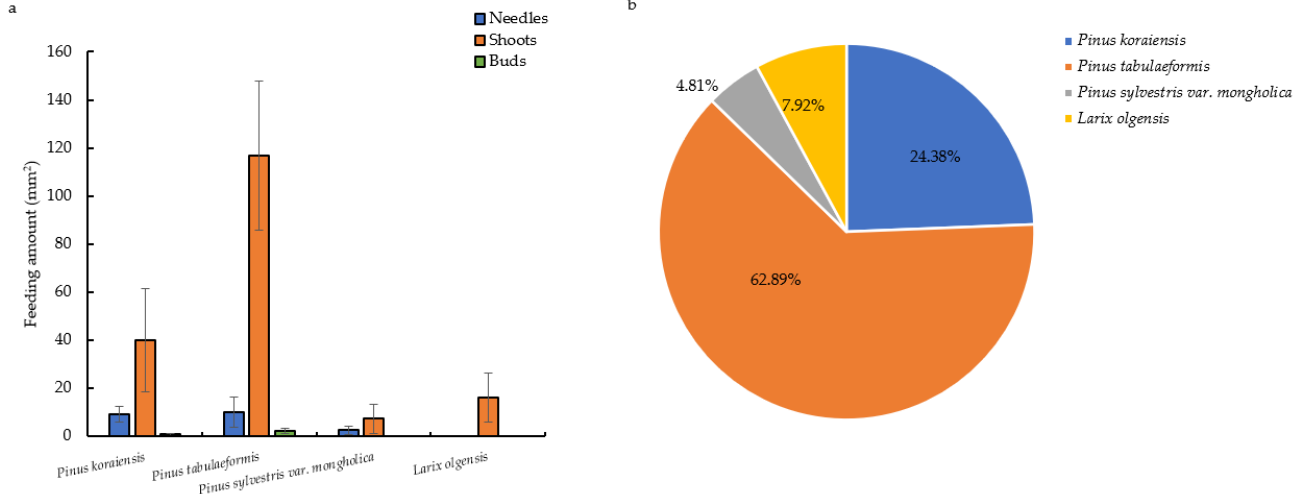
Figure 1. Feeding preference of Monochamus saltuarius adults on different host pine trees. ( a ) Average daily feeding amount of Monochamus saltuarius adults on different host pine trees; ( b ) Feeding ratio of Monochamus saltuarius adults on different host pine trees.